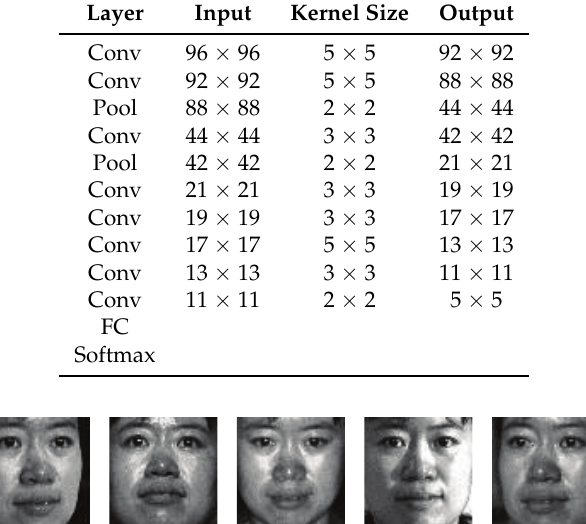
Figure 15. Some images of CMU-PIE